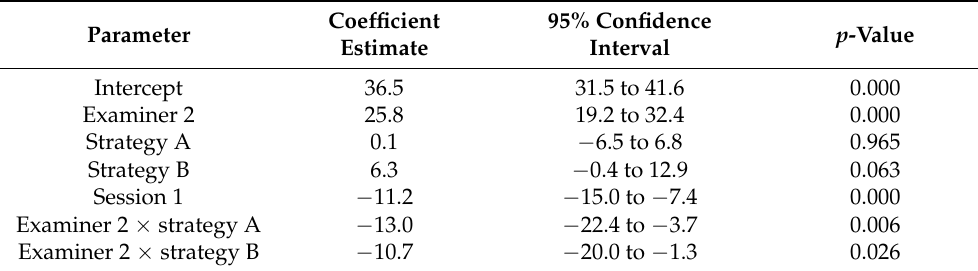
Table 3. Results parameter estimates of the General Linear Model.